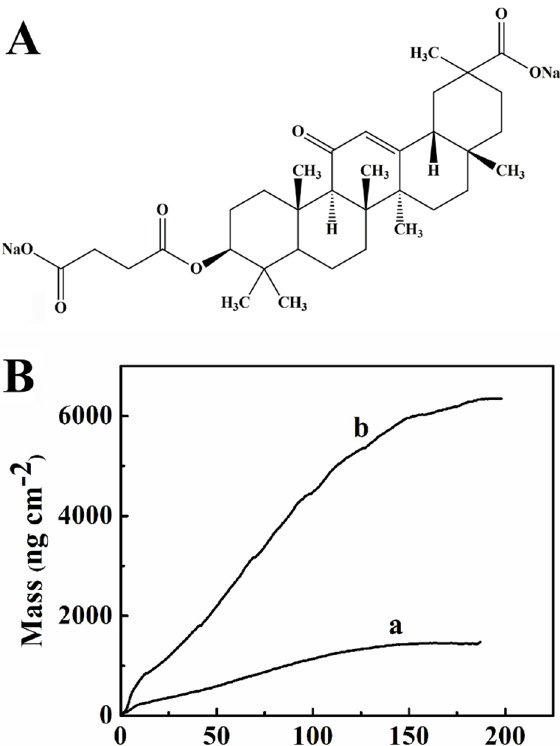
Figure 1. ( A ) CBXNa 2 structure, ( B ) film mass as a function of time analyzed in situ using QCM for 0.1 gL − 1 CBXNa 2 solutions in water at deposition voltages of (a) 3 and (b) 5V.